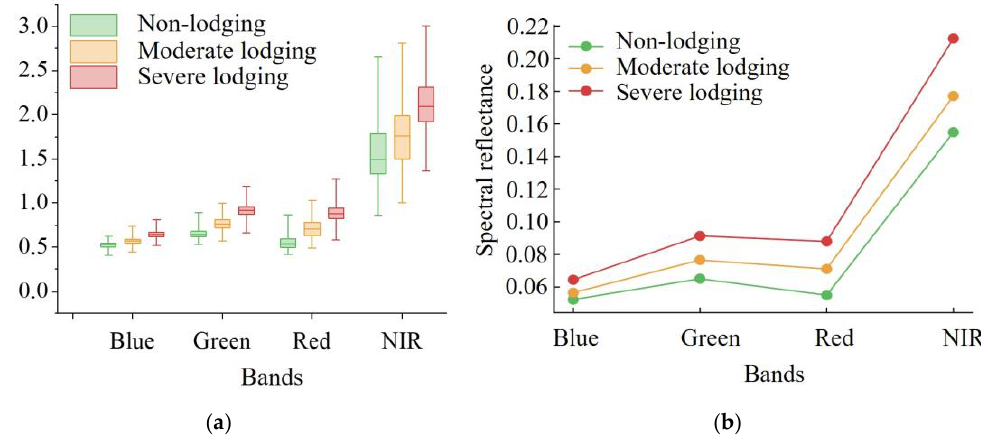
Figure 4. The boxplot ( a ) and spectral difference ( b ) of the non-lodged, moderately lodged, and severely lodged areas within four spectral bands.